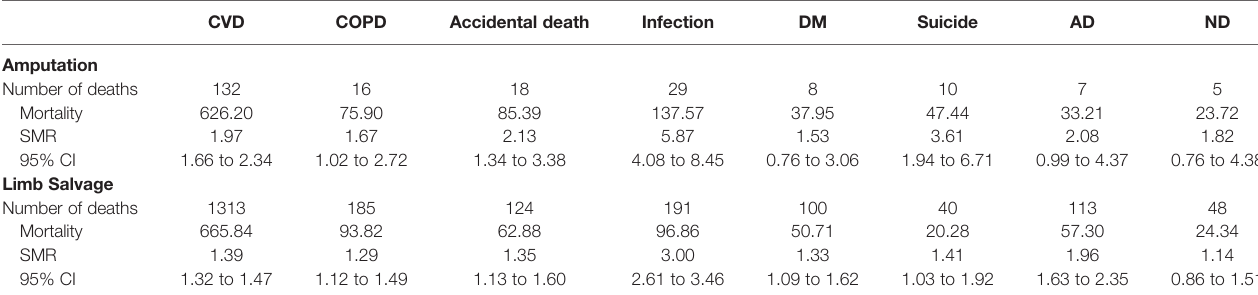
TABLE 3 | The comparison of the risk of dying from some non-cancer diseases between survivors after limb salvage and those after amputation. CVD COPD Accidental death Infection DM Suicide